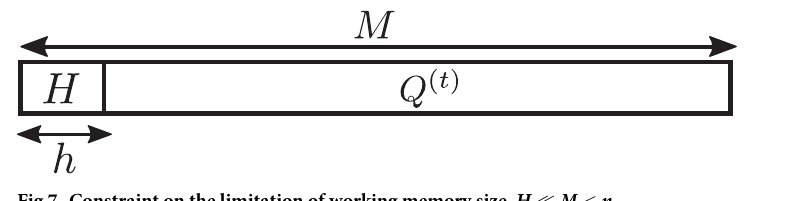
Fig 7. Constraint on the limitation of working memory size, H � M < n